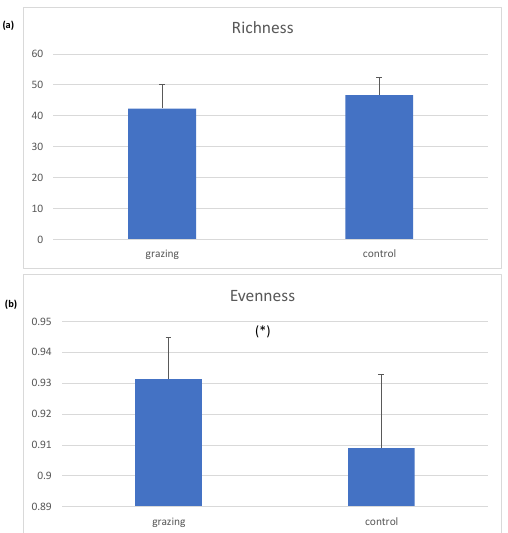
Figure 2. Mean values and standard deviations for ( a ) total species richness and ( b ) evenness for grazing and control plots. (*) For significant differences ( p < 0.05). The CCA analysis revealed that of all the physical parameters analyzed, only three were significant for the distribution of the species composition: grass cover, canopy cover, and soil total nitrogen. First, the CCA axis discriminated grazed vs. control plots, with grass cover more representative in the control plots and canopy cover more representative in the grazed plots. However, axis 2 was related to %TN with higher values in the grazed plots (Figure 3). In the case of the species, a gradient of variation in species composition was revealed from control to grazed plots. Differences between treatments based on species cover were significant (MRPP) with a T = −7.102 and group probability correction of A = 0.087 for a p < 0.01. Finally, the ISA base in 1000 permutations revealed that the indicator species for the grazed plots were Bouteloua dactyloides , Crusea diversifolia, and Dichondra brachypoda , while Dalea radicans , Muhlenbergia rigida (Kunth) Kunth, Arbutus xalapensis , Hedeoma costata A. Gray, Juniperus deppeana , and Malaxis brachystachys (Lindl.) Rchb. f. were indicators for the control plots ( p < 0.01 for all species). These indicator species were represented in the CCA biplot in bold letters (Figure 4). Table 1. General abiotic information of experimental plots and soil nutrients and characteristics of experimental plots. The values′ average (Avg) and standard deviations (Std) for grazed and control plots are included.